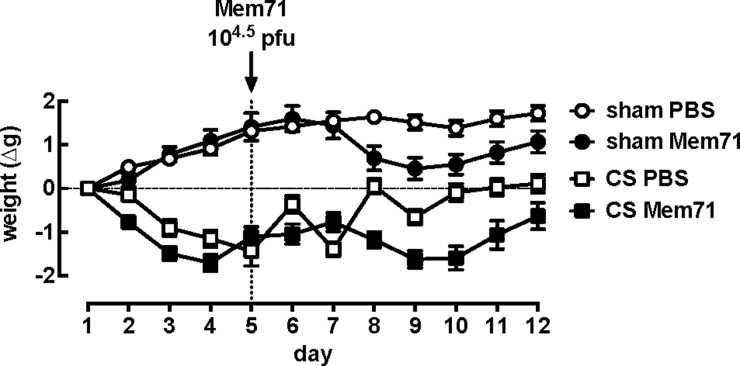
Mouse weights from sham or CS mice treated with PBS or Mem71 over the 12 day protocolMice were exposed to air (sham) or CS for 4 days. On day 5, mice were administered 30 μl of PBS or 104.5 PFU of Mem71 intranasally. All mice (sham PBS, CS PBS, sham Mem71 and CS Mem71) were weighed daily at 8:45 hours until day 12 (7 days post-infection). Data are expressed as mean ± S.E.M. as a change in weight from day 1 (n=10 per group).